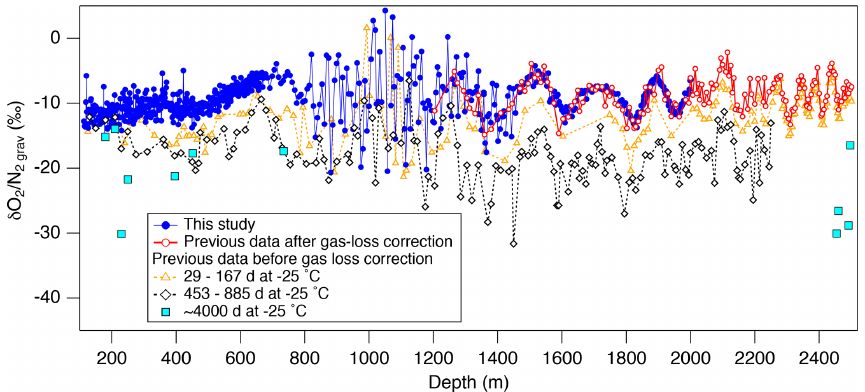
Figure 5. Comparison of the new and previous δ O 2 / N 2gravcorr data from the Dome Fuji ice core. Solid circles (blue) are the new data (this study), and open circles (red) are the previous data corrected for gas loss during storage at − 25 ◦ C (Kawamura et al., 2007). Open triangles (orange), open diamonds (black), and the solid square (light blue) are the uncorrected previous data for the storage period of 29–167, 453– 885d (Kawamura, 2001) and ∼ 4000d (11 years) (this study),